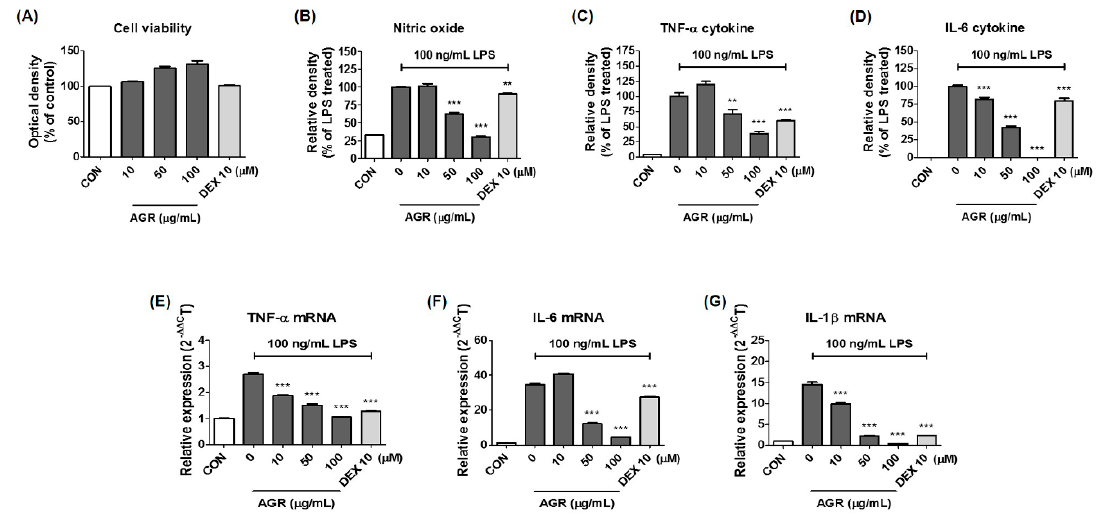
Figure 1. Effects of AGR on ( A ) cell viability, secretion of ( B ) NO, ( C , D ) inflammatory cytokines, and ( E – G ) mRNA expression in BV2 microglia. Control cells were incubated with vehicle alone. Data represent the mean ± SEM of determinations from three independent experiments. p values (** p < 0.001 and *** p < 0.0001) were calculated from comparisons with LPS stimulation values.